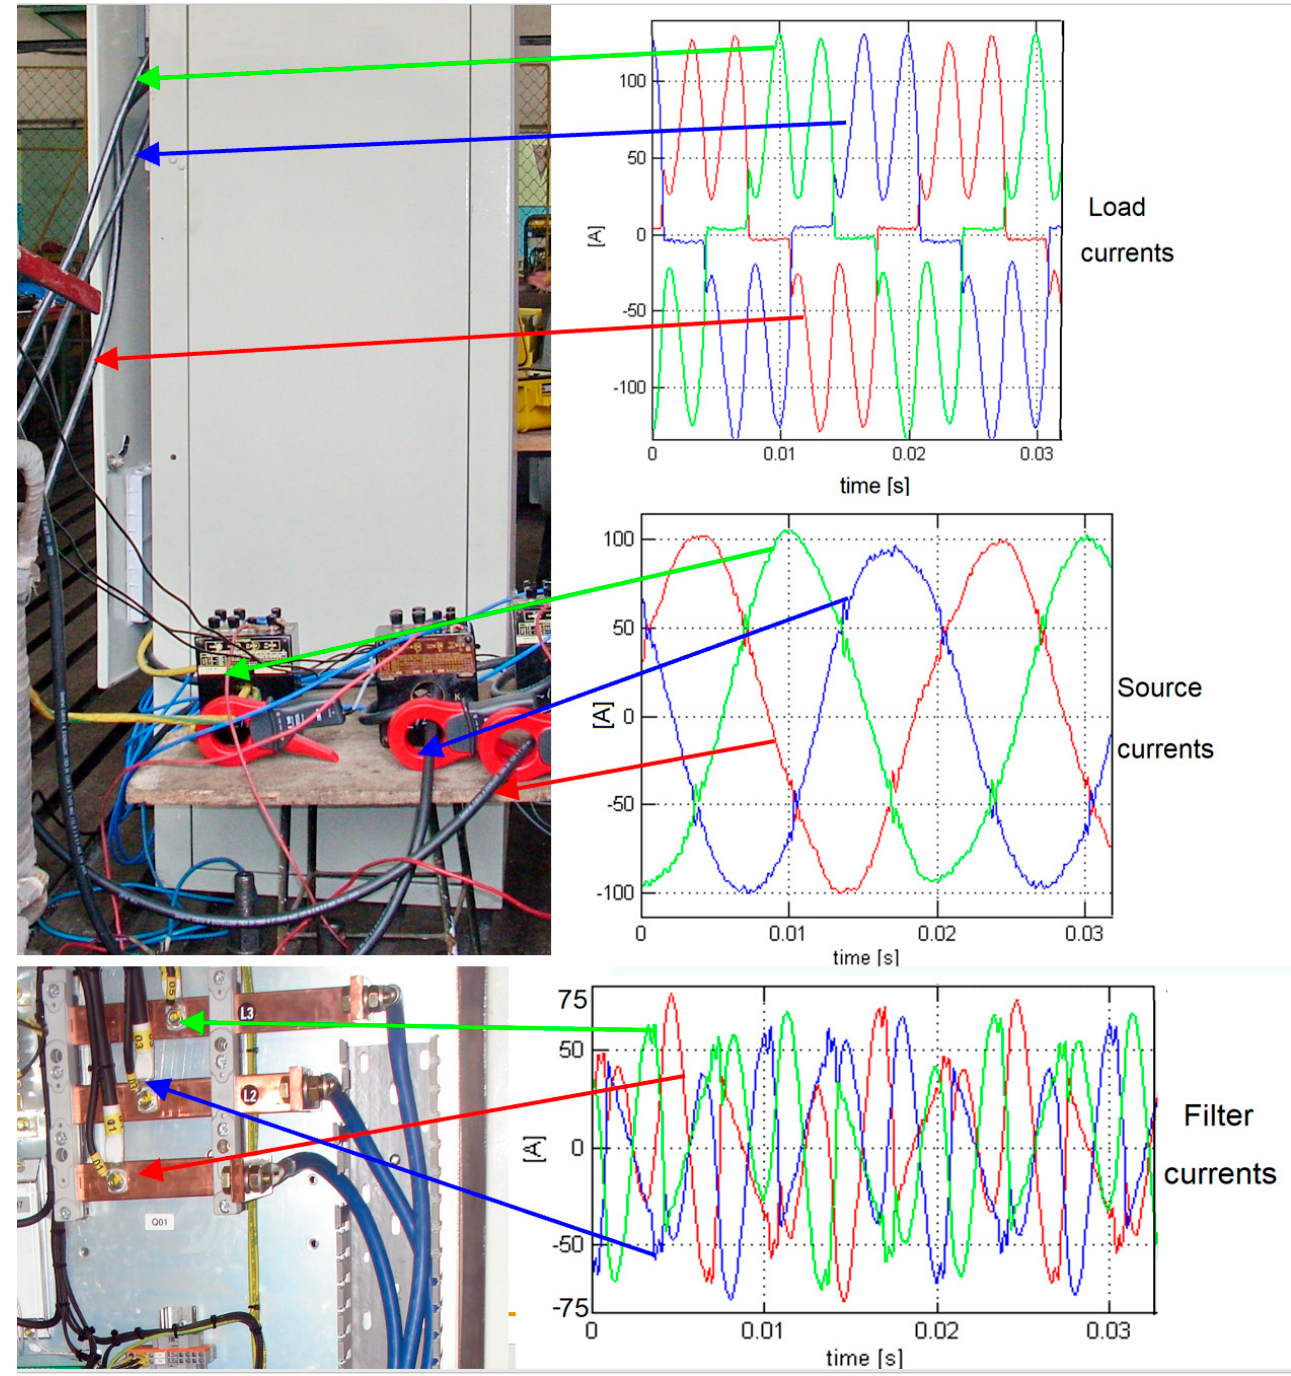
Figure 15. (Right) The currents before ( top ) and after compensation ( middle ) and currents through filter ( bottom ) for a RMS value of 100 A per phase (case α ). ( Left ) Test points. Test II.